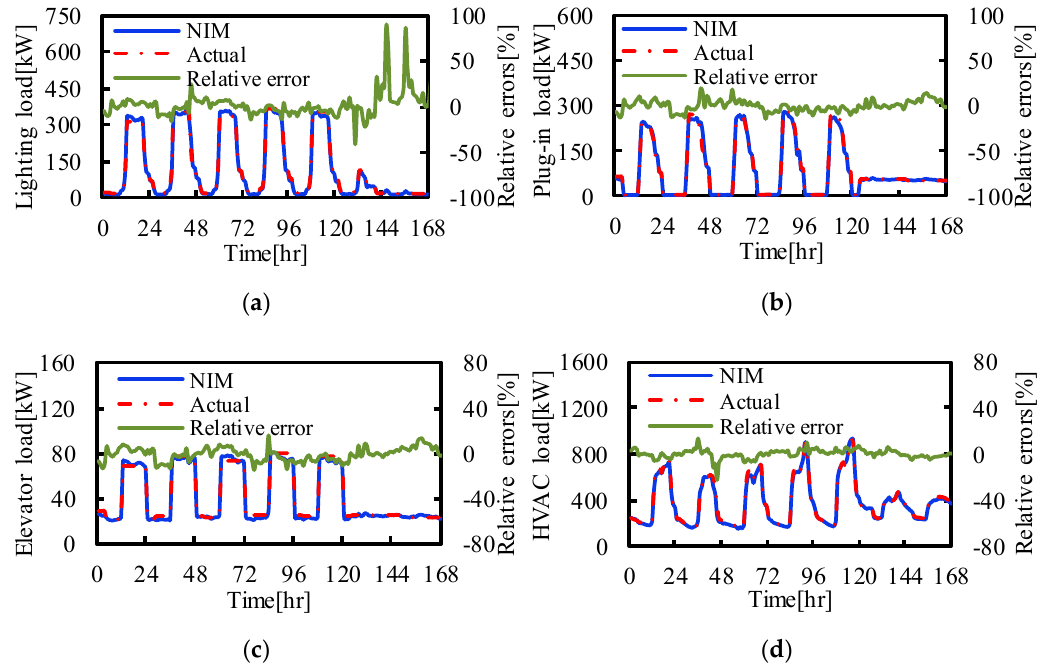
Figure 6. Testing results of the NIM model based on Approach I in a typical week: ( a ) the comparison results of lighting system load; ( b ) the comparison results of plug-in system load; ( c ) the comparison results of elevator system load; ( d ) the comparison results of HVAC system load.